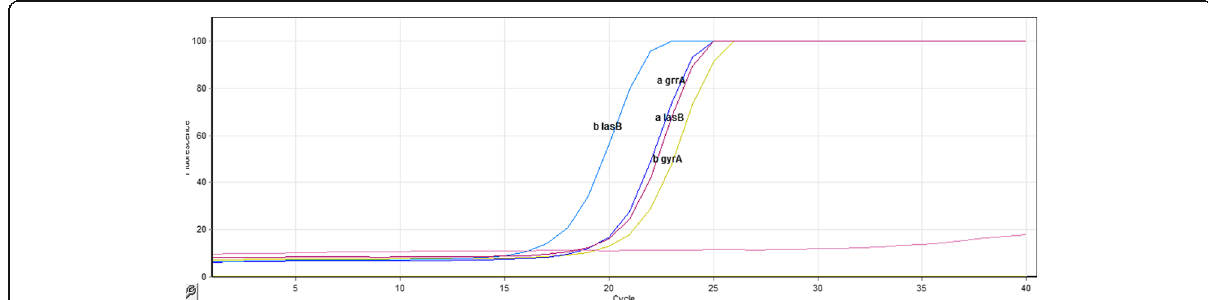
Fig. 3 lasB gene amplification curve using Real-time RT-PCR technique: As outlined in the figure, the Ct level of the lasB gene was different before and after treatment (Ct before treatment = 13.24 and Ct after treatment = 12.64). However, there was no change in the Ct level of the gyrA gene before and after treatment (Ct before treatment= 14.56 and Ct after treatment= 14.06). Therefore, the amount of the lasB gene expression changed after treatment, while the gyrA gene expression had no change before and after